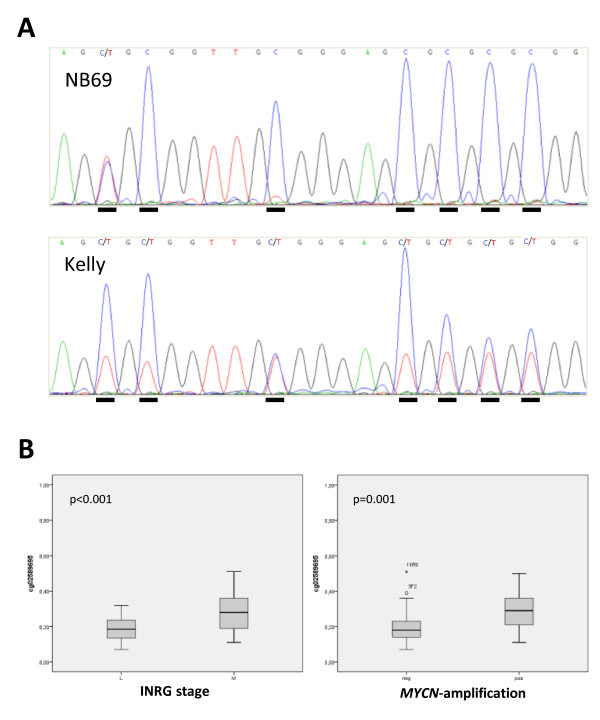
RASSF5 methylation and correlation to INRG stage and MYCN amplification. (A) Examples of bisulfite sequencing of RASSF5in the RASSF5A  CpG island: top sequence NB69 and bottom sequence Kelly. CpG sites are underlined and C in the sequence indicates methylation and C/T in the sequence indicate partial methylation. (B) High methylation of RASSF5  is significantly correlated to INRG stage M and MYCN  amplification. P-values are indicated in the left upper corner in each graph. Box plot explanation; upper and lower hinges of the box represent the 75th percentile and 25th respectively; whiskers show highest and lowest values. Open circles represent outliers and asterisks show extremes.